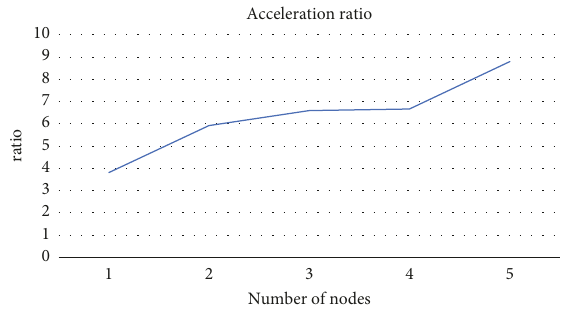
Figure 6: Acceleration ratio of different nodes.